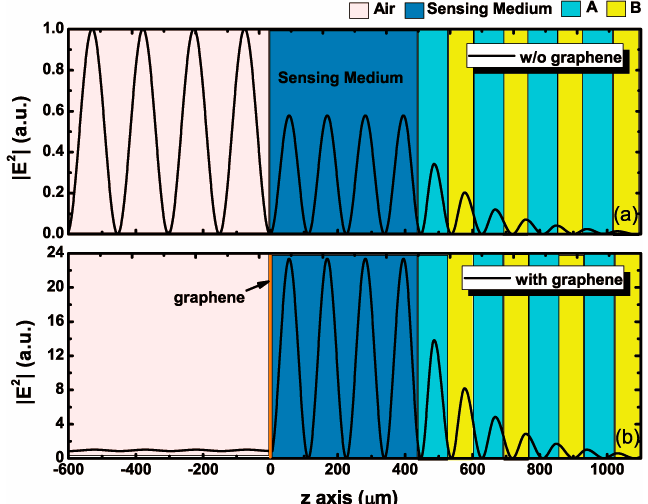
Figure 3. ( a ) The normalized electric field distributions in the proposed structure in absence of monolayer graphene. ( b ) The normalized electric field distributions in the proposed strcture coated with monolayer graphene.